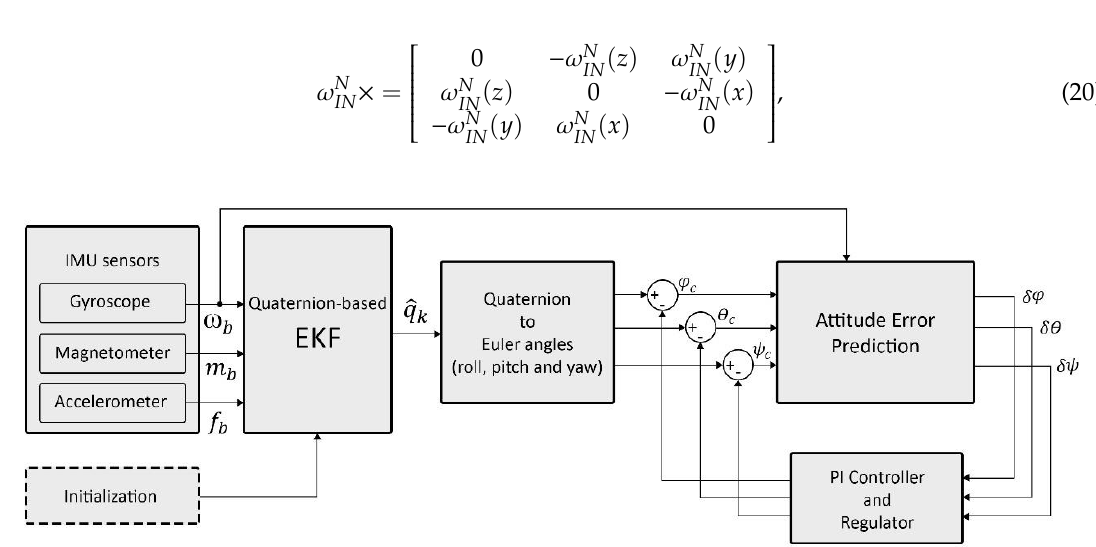
Figure 1. Overview of the attitude and heading reference system (AHRS) method with error prediction filter, proprtional integral (PI) controller, and regulator.